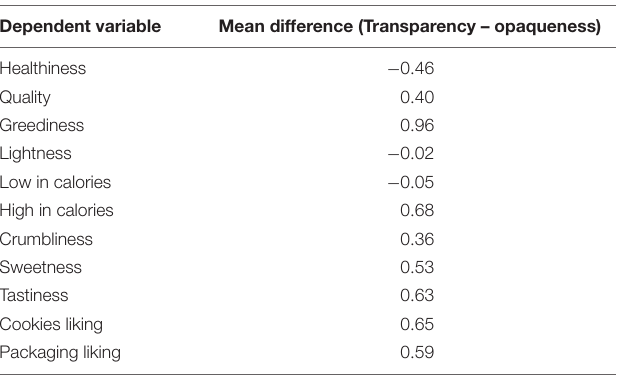
TABLE 6 | Mean differences for general transparency vs. opaqueness, and regardless of type (jar vs. bag) and labeling (presence vs. absence) of the